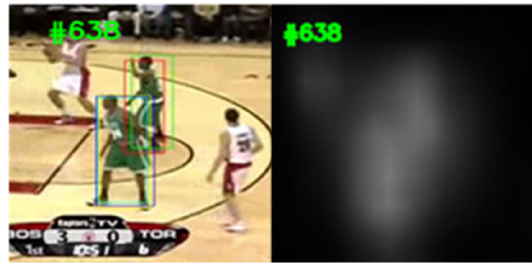
Figure 3. Similarity map with distractor. Table 1. Challenge